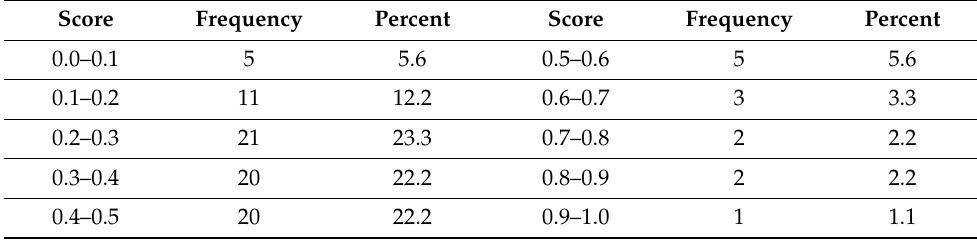
Table 6. Frequency table of bootstrap DEA